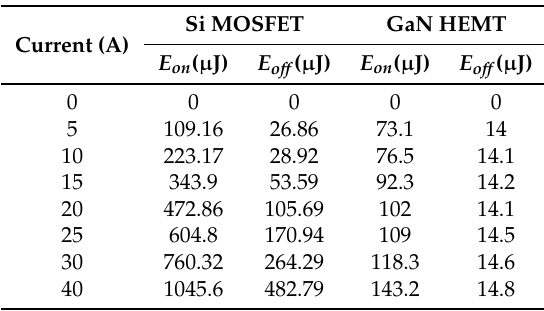
Figure 8. Turn-on and Turn-off switching energy losses of Si MOSFET and GaN HEMT: ( a ) Turn-On; ( b ) Turn-Off. Table 3. Switching energy losses.